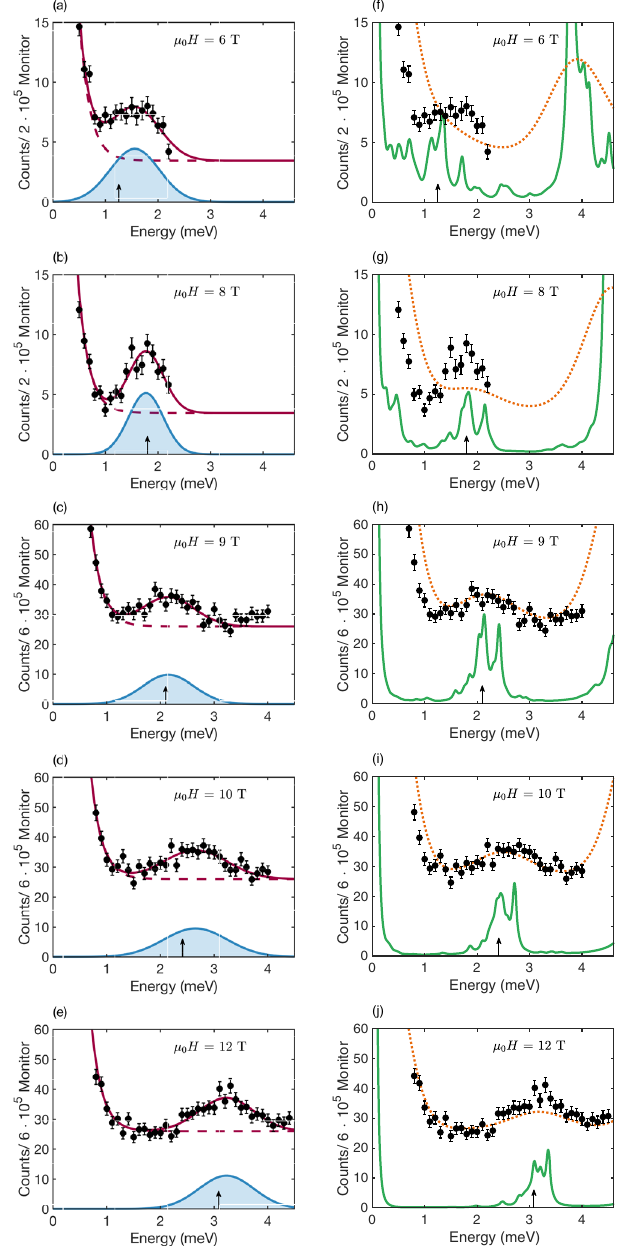
Fig. 5 Inelastic Neutron Scattering excitation spectra. Neutron scattering intensity for magnetic fi elds of 6 T, 8 T, 9 T, 10 T and 12 T. Panels a – e show excitation spectra together with the fi t to the data (solid red lines) and background (dashed red lines) described in the main text and the shaded blue area to their difference — the MBO signal. Black arrows are the predicted effective Bloch energies, _ ω (cid:5) equation (7). Panels f – j show excitation spectra together with the RPA calculations of the spectra (solid green line) and the RPA calculations with a Gaussian convolution (dashed orange line) as described in the main text. a , b , f – g Data measured at MACS, averaged over the momentum range Q L = 0.9 – 1.0 r.l.u. at magnetic fi elds of 6 T and 8 T. c – e , h – j Data measured at ThALES at Q L = 1.0 r.l.u 31 at magnetic fi elds of 9 T, 10 T and 12 T. Please note the different energy transfer range of the two experiments (see Methods). Error bars represent one standard